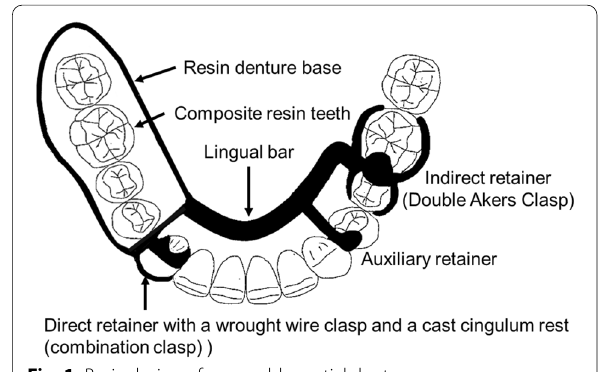
Fig. 1 Basic design of removable partial denture